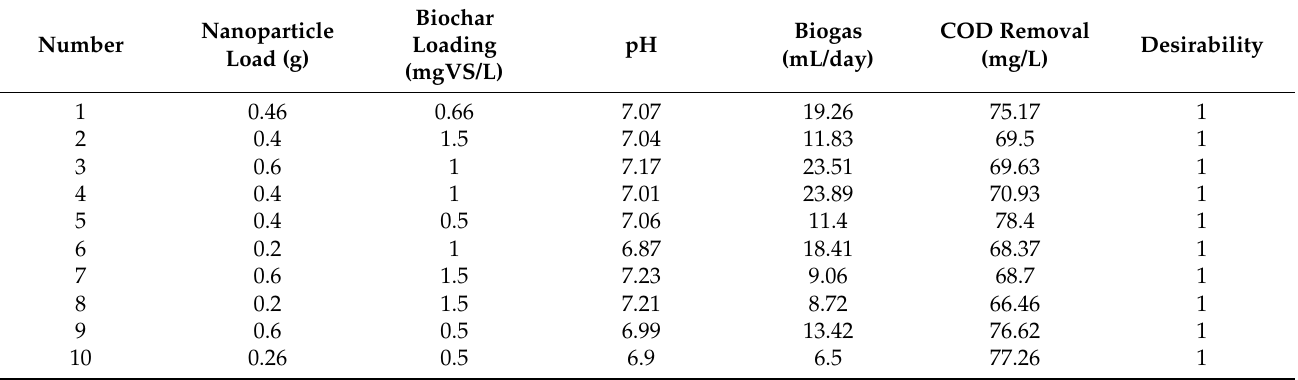
Figure 5. Ramp plot of the optimization result of methane production and COD reduction. Table 5. Selected optimized